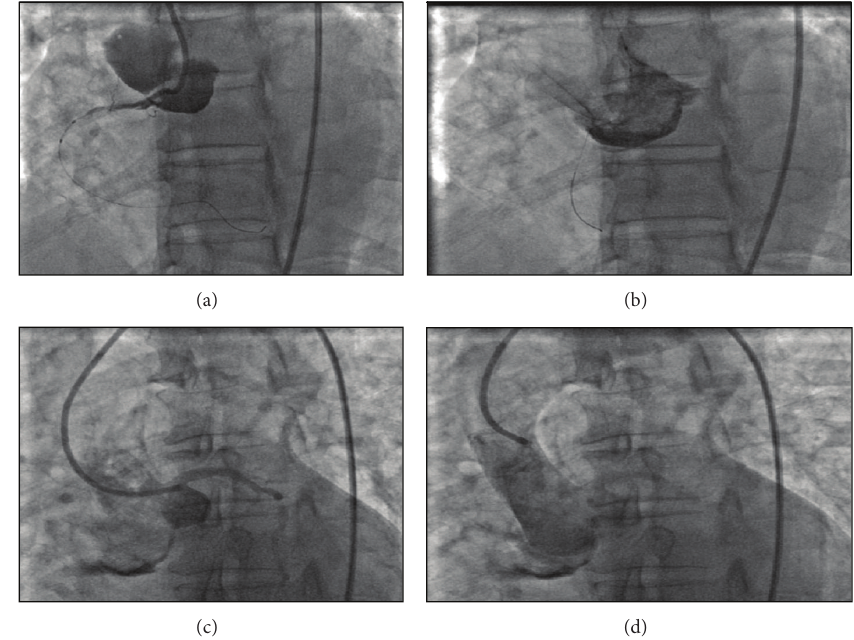
Figure 3: (a) Acute aortic dissection at the time of dye injection with the guide catheter and wire in place. (b) Visualization of the extent of dissection after injection of the dye. (c) Dye injection into left main coronary, no propagation to left coronary artery. (d) Aortogram showing dye staining of the aortic root dissection.